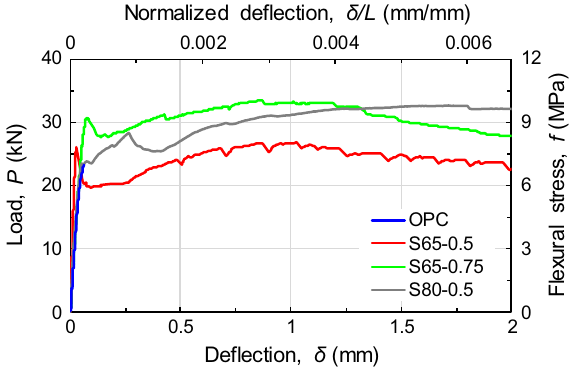
Fig. 8 Flexural load versus deflection curves (four-point